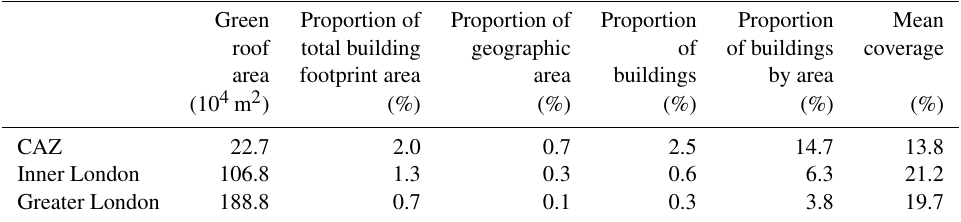
Table 9. Table of estimated green roof area for the CAZ, Inner London, and Greater London in 2021. Green Proportion of Proportion of Proportion Proportion Mean roof total building geographic of of buildings coverage